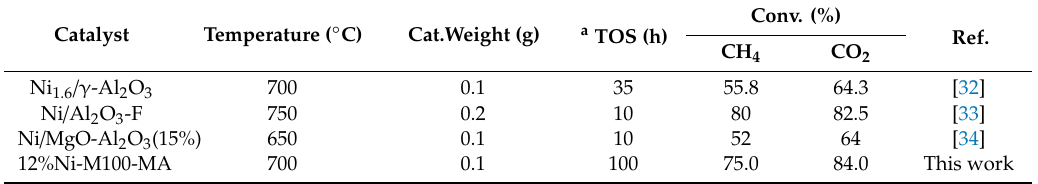
Table 2. Comparison with previous literature.